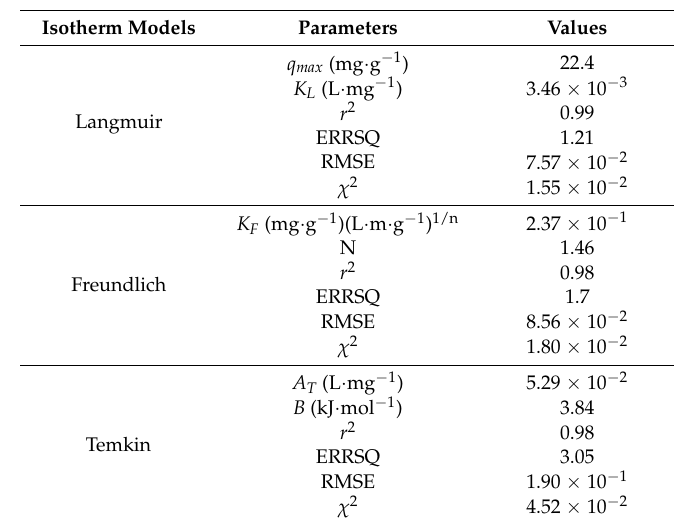
Figure 13. Langmuir, Freundlich, and Temkin equilibrium isotherm models for Cd(II) sorption on YTBS residue. Table 6. Isotherm model parameters for sorption of Cd(II) onto YTBS adsorbent.